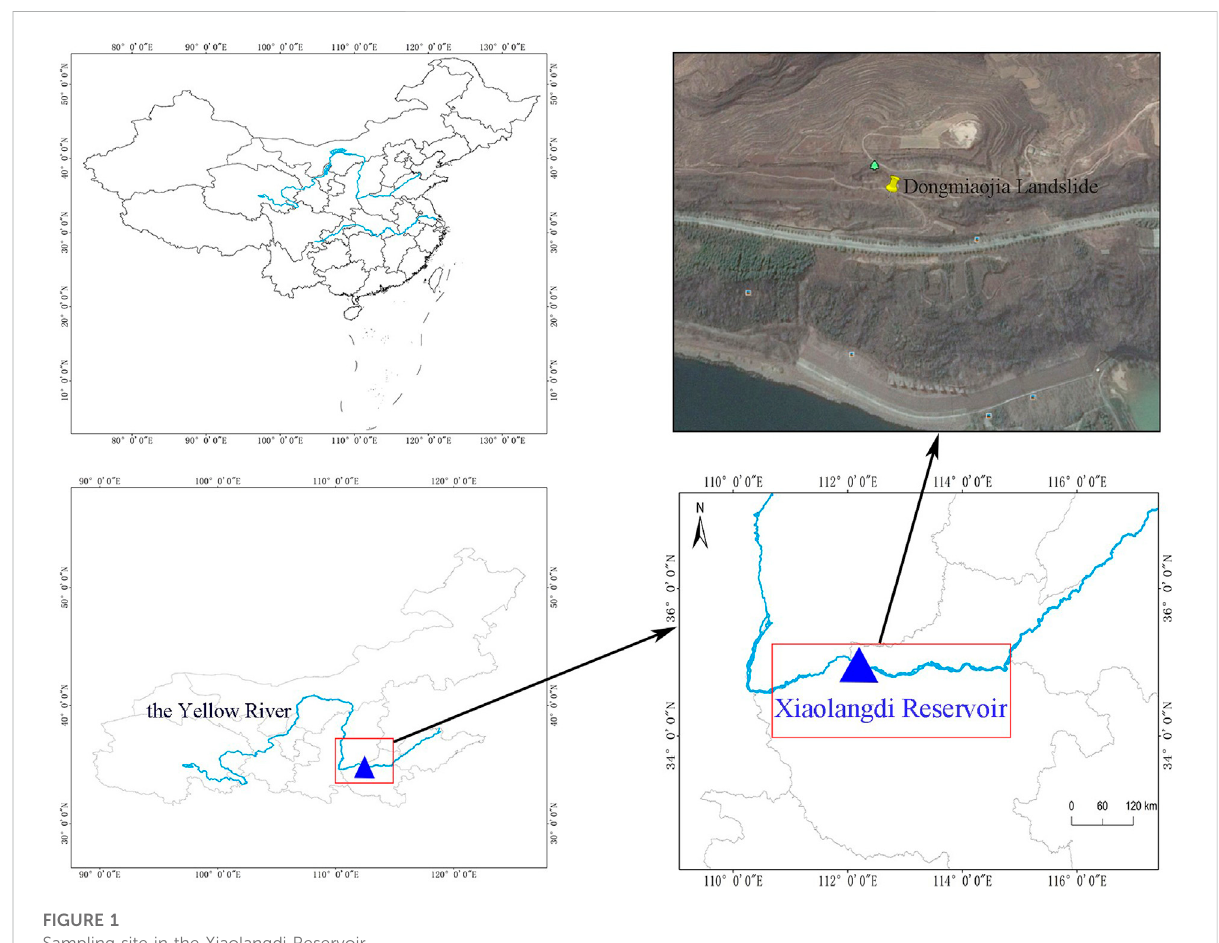
FIGURE 1 Sampling site in the Xiaolangdi